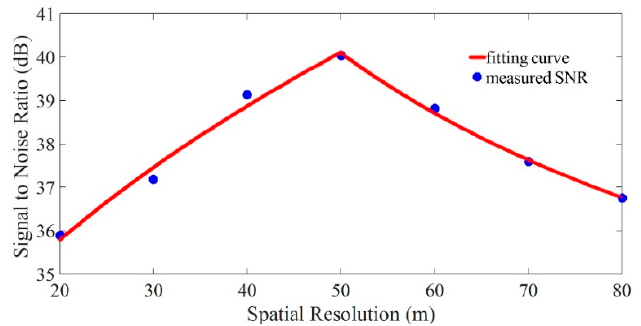
Figure 1. The curve of measured signal-to-noise ratio (SNR) changed with spatial resolution (SR).